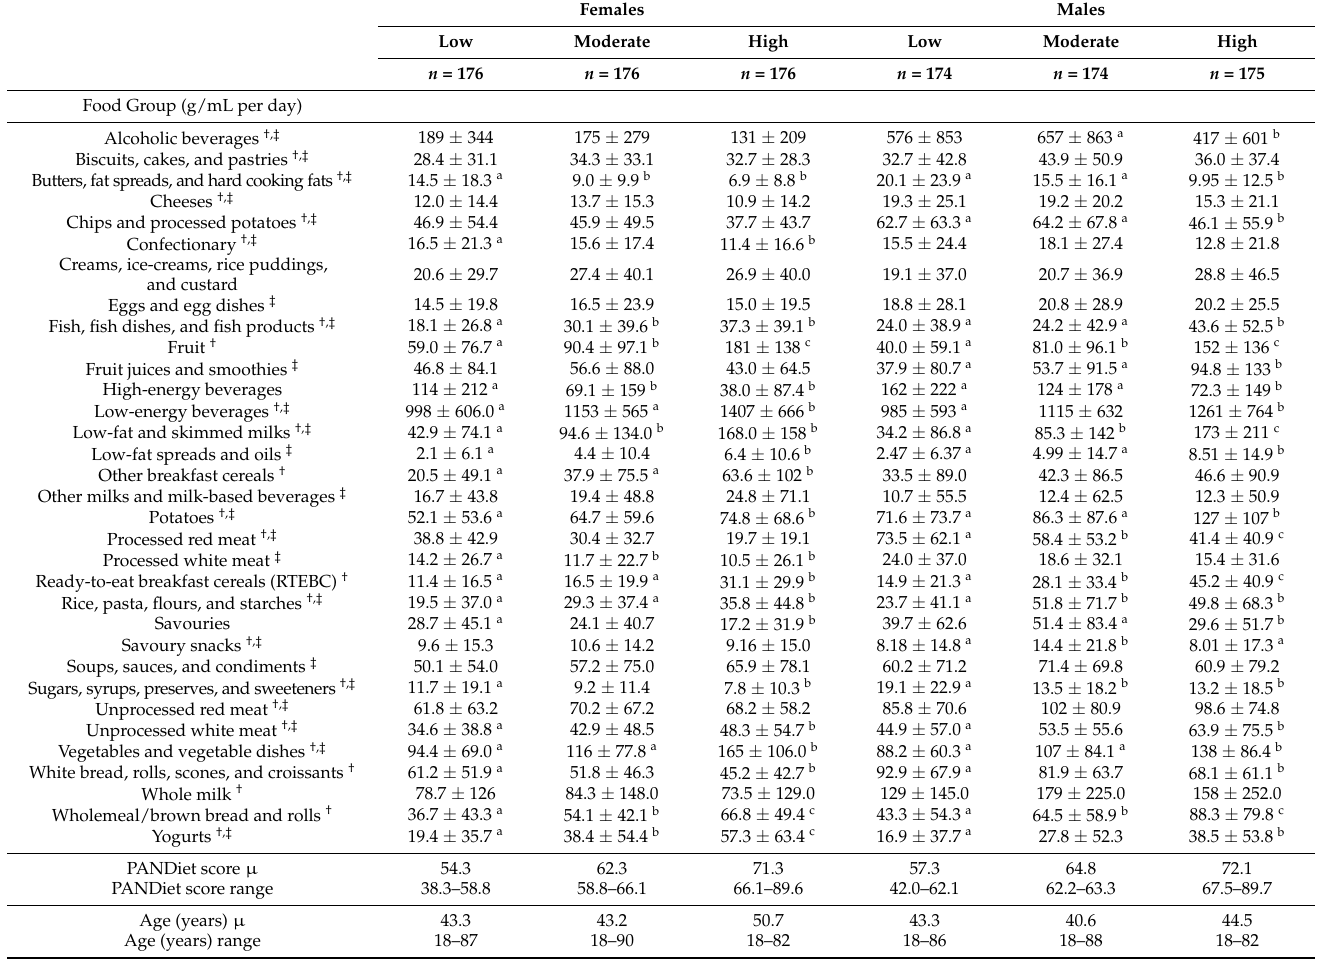
Table 4. Food group intakes across low, moderate, and high PANDiet scores spilt by genders. Females Males